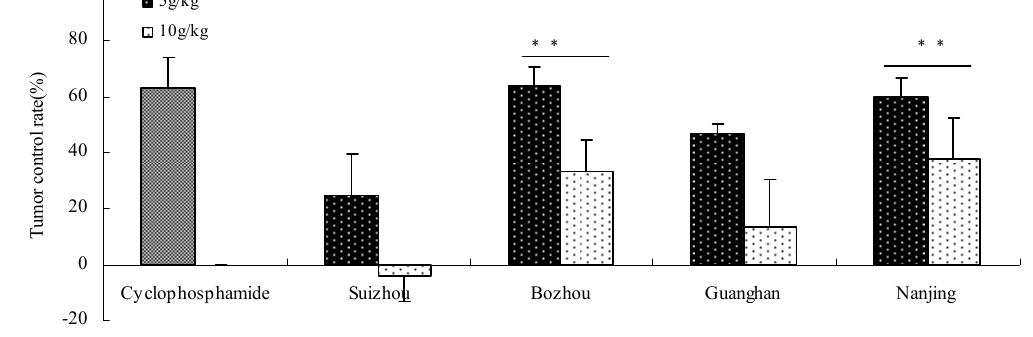
Figure 2. Inhibition activity on lung cancer in vivo.